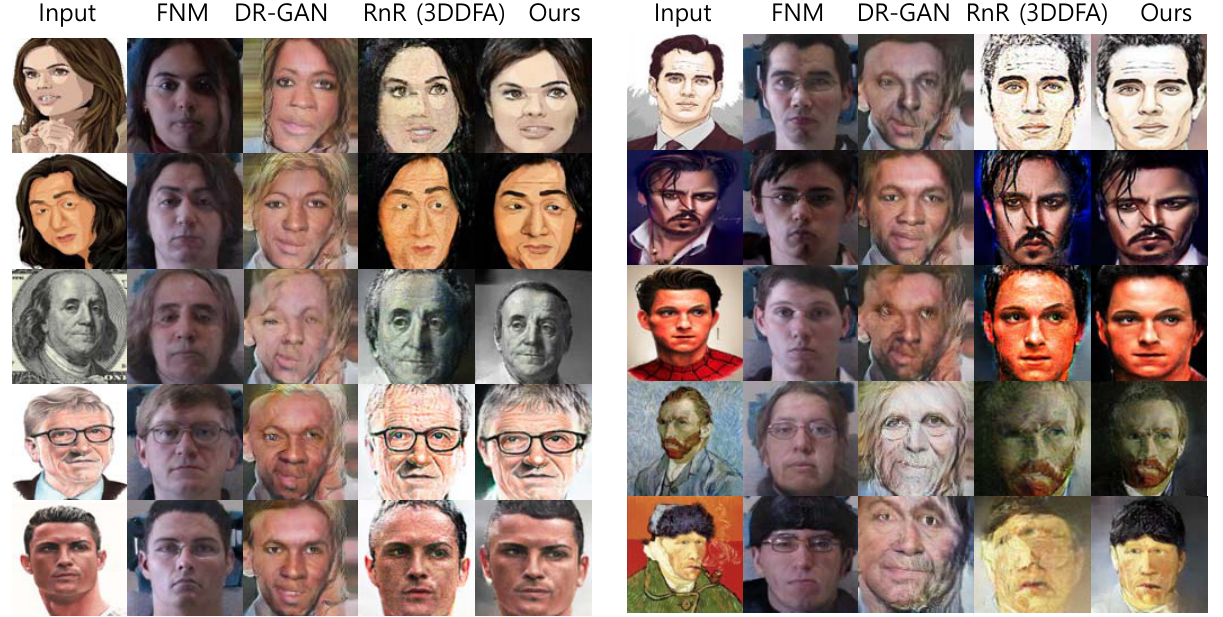
Figure 12. Comparison of our results with existing works: FNM [29], DR-GAN [26] and Rotate-and- Render (RnR) [3]. Rotate-and-Render is implemented based on 3DDFA